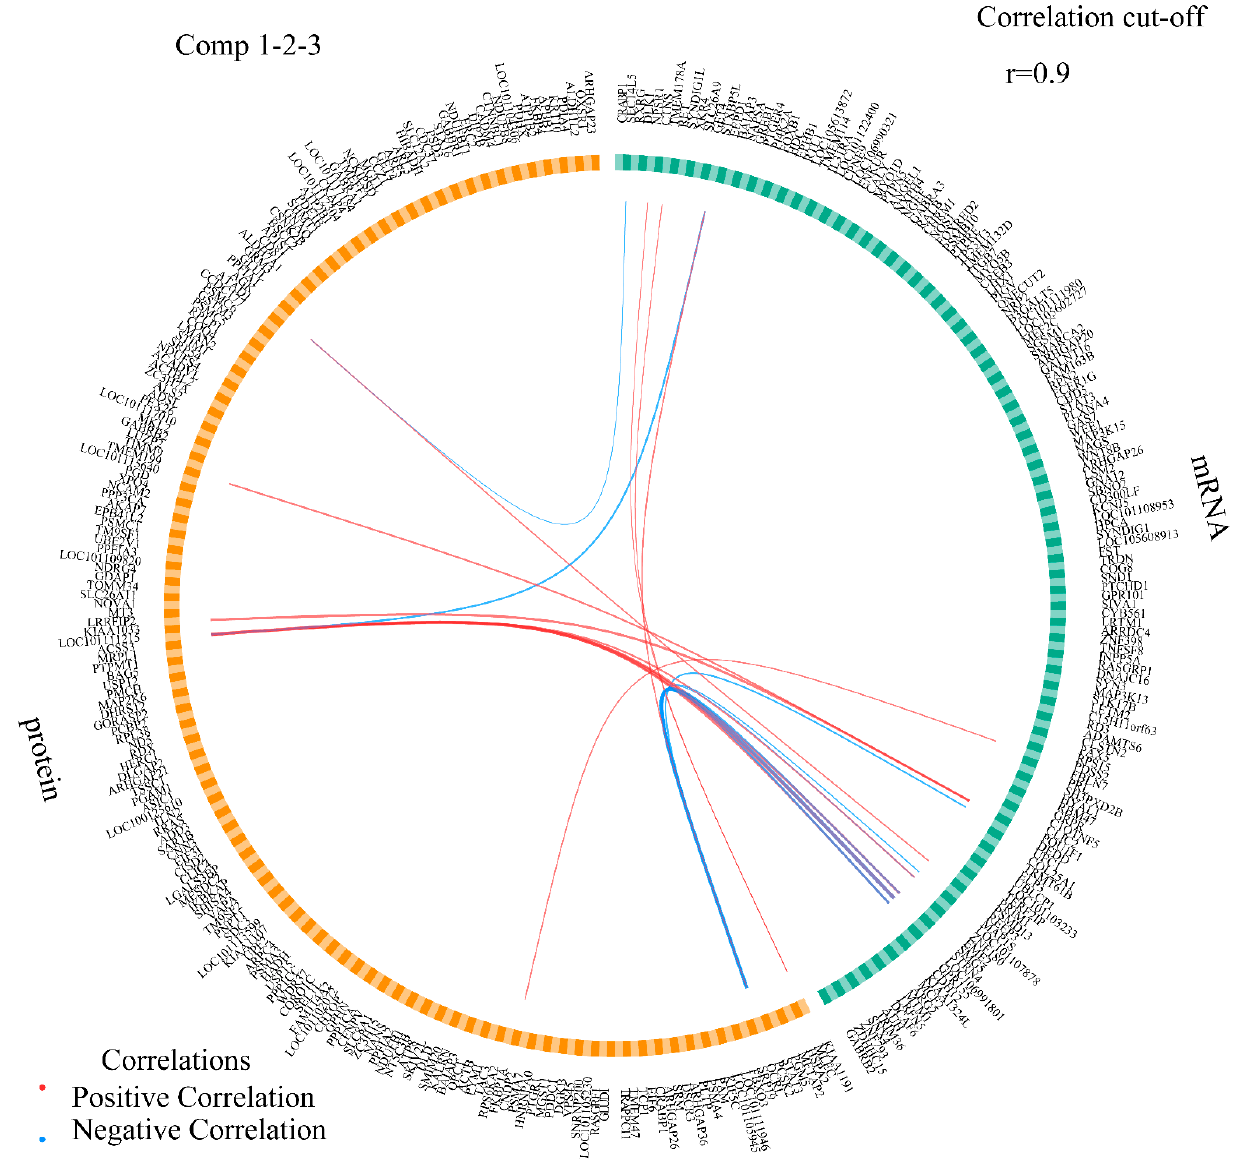
Figure 5. A Circos plot displays the positive (red lines) and negative (blue lines) correlations (r > 0.9) between feature variables in the